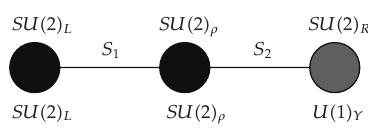
Figure 3: Diagram of the 3-site